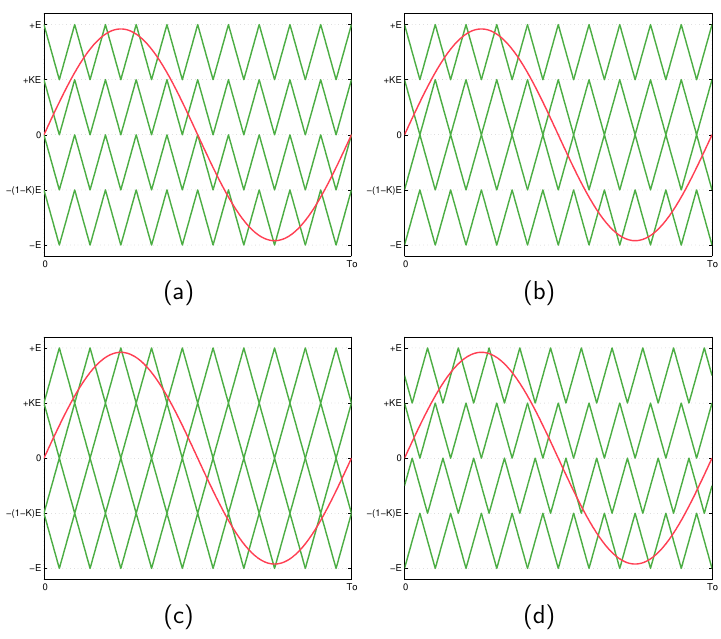
Figure 2. Types of disposition for vertical multicarrier sinusoidal pulse width modulation (SPWM): ( a ) phase disposition (PD), ( b ) phase opposition disposition (POD), ( c ) alternative phase opposition disposition (APOD), and ( d ) phase shift (PS). In the vertical axis, there are N M f = 10 is selected for the horizontal axis for the sake of easiness. Note that there are M f switching intervals. Only one of the carriers is active for comparison with the modulating signal M a .